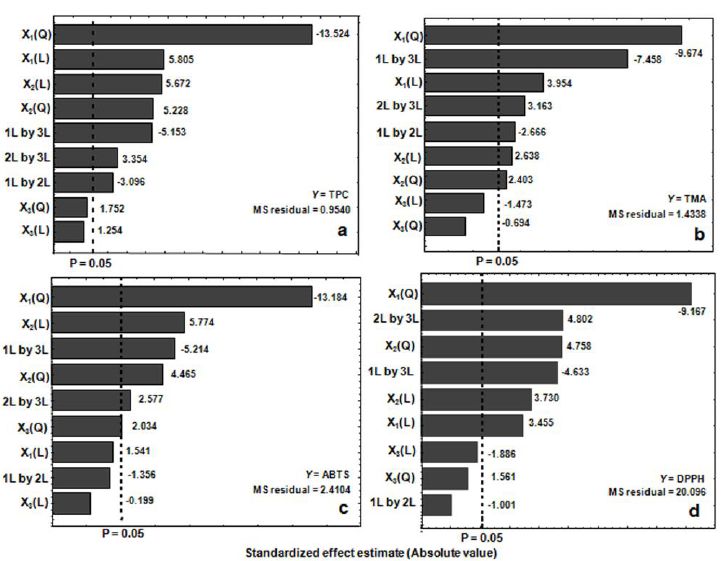
Figure 1. Pareto chart of the standardized effects of the three factors and three levels of Box–Behnken design for Brosimum alicastrum leaf-extract. ( a ) total phenolic content; ( b ) total monomeric anthocyanin; ( c ) ABTS; ( d ) DPPH. The vertical dashed line indicates the significance level at p = 0.05. The t -test value for each effect is shown in the Pareto chart by horizontal